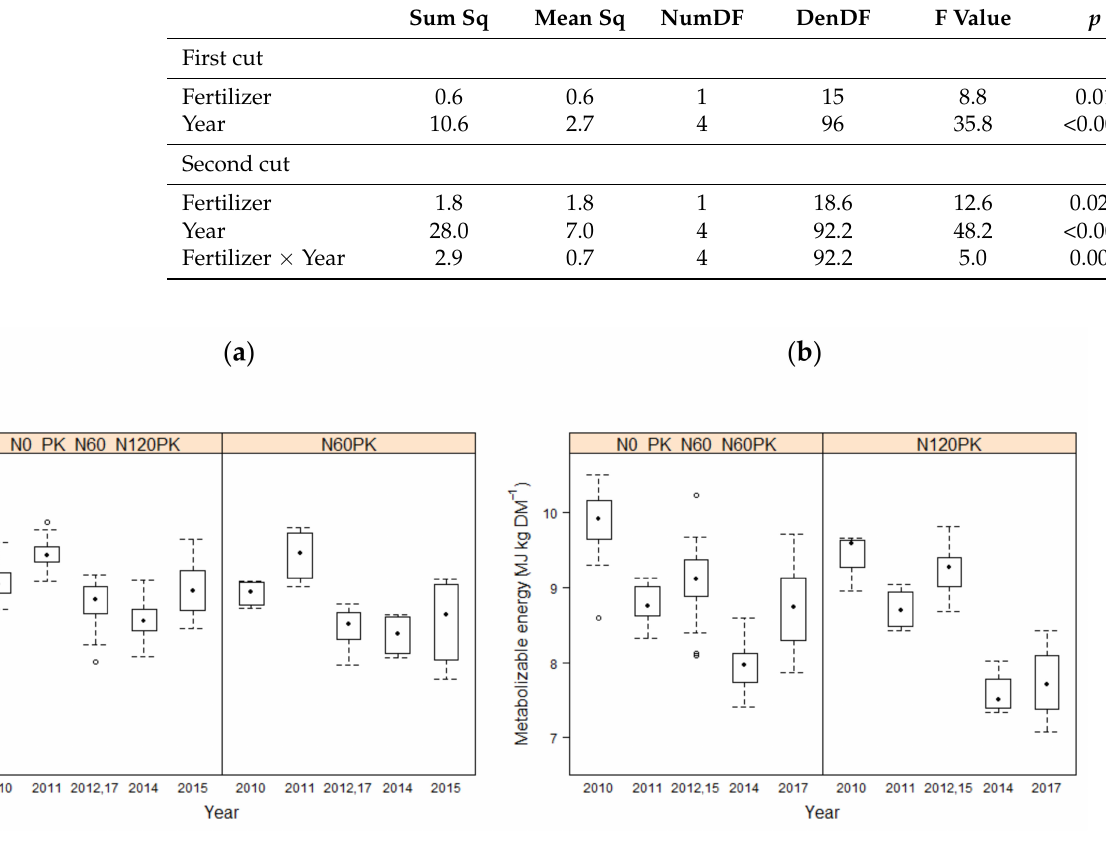
Figure 3. The minimal adequate model for the effect of fertilization treatment and time on the metabolizable energy (MJ kg DM − 1 ) for the first ( a ) and second ( b ) cuts with different fertilization treatments between 2010 and 2017 (except 2013 and 2016). Level needed for female sheep (70–100 kg): 8.7–8.8 MJ kg DM − 1 , for ewes (70–100 kg) rearing a single lamb: 10.4–10.7 MJ kg DM − 1 , for rams 100–120 kg: 9.4 MJ kg DM − 1 , for rams in the breeding season: 10.0 MJ kg DM − 1